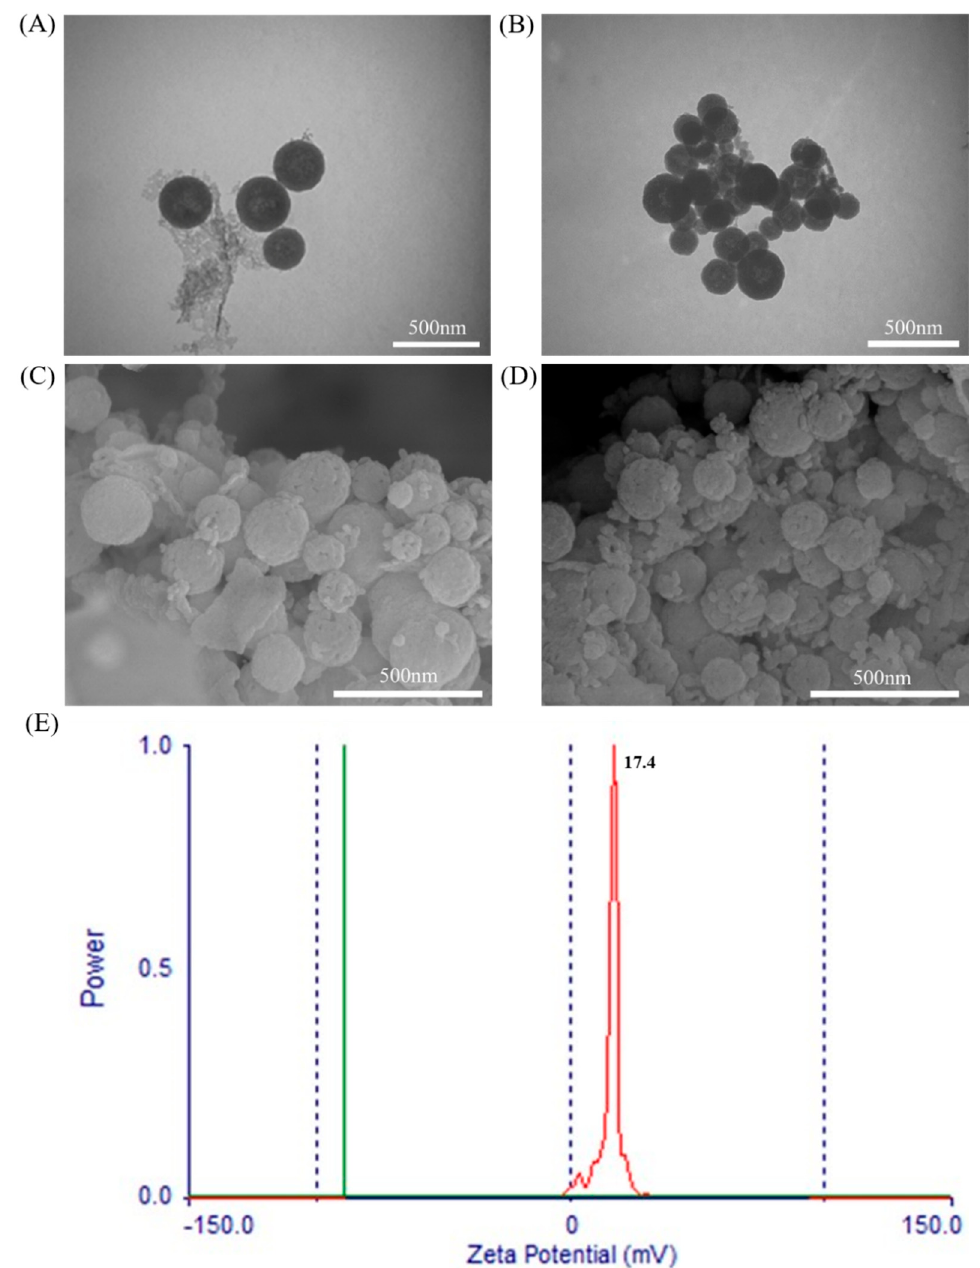
Figure 3. Transmission electron micrograph (TEM) and scanning electron micrograph (SEM) of aminated mesoporous SiO 2 nanoparticles: ( A ) TEM image of the unaminated mesoporous SiO 2 nanoparticles; ( B ) TEM image of mesoporous SiO 2 nanoparticles after amination; ( C ) SEM image of the unaminated mesoporous SiO 2 nanoparticles; ( D ) after amination SEM image of mesoporous SiO 2 nanoparticles; ( E ) Zeta potential of aminated mesoporous SiO 2